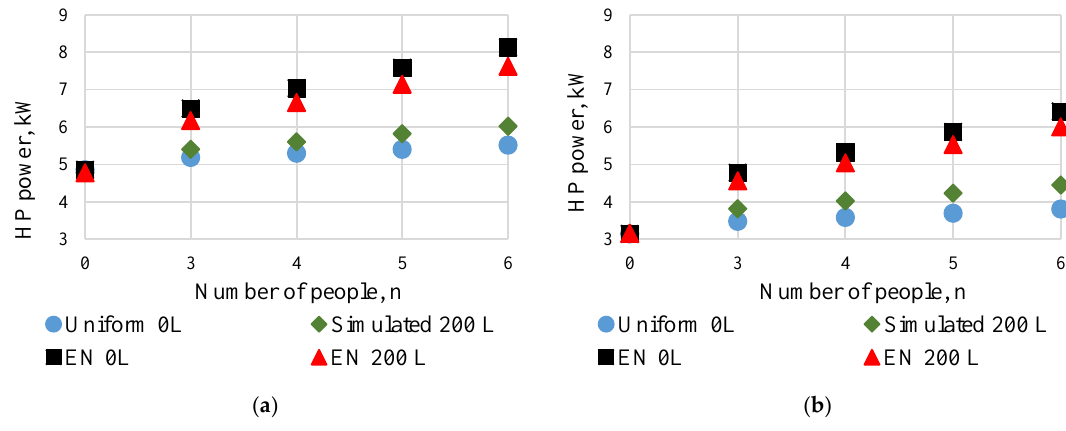
Figure 11. GSHP powers for design outdoor temperature of ( a ) − 26 °C and ( b ) − 15 °C.